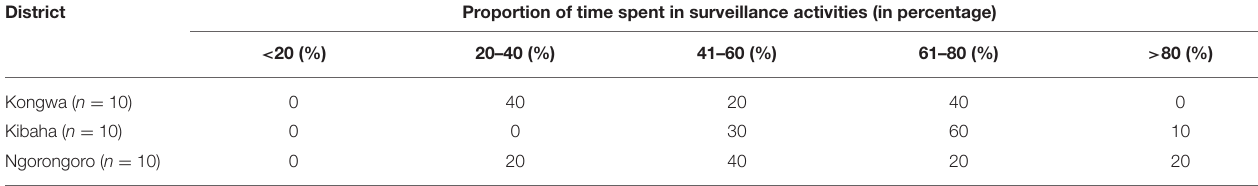
TABLE 3 | Proportion of time district level animal health officials spent on surveillance activities. District